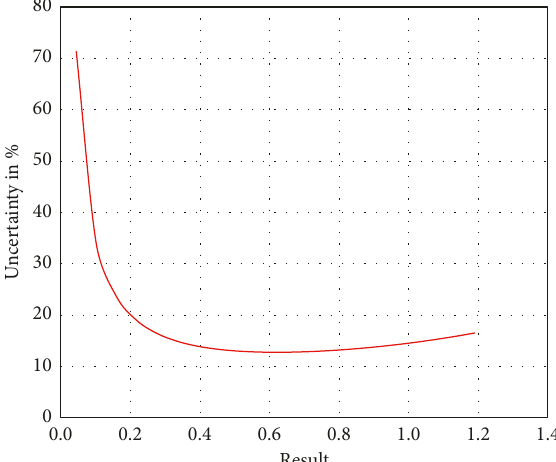
Figure 9: MOAH uncertainty (%) as a function of result of MOAH in lip